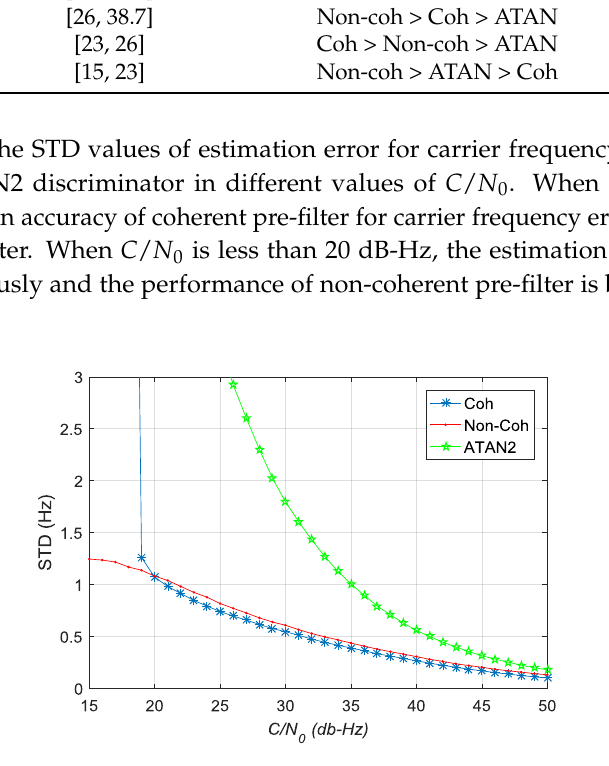
Figure 15. The STD values of estimation error of carrier frequency error in different C / N 0 .